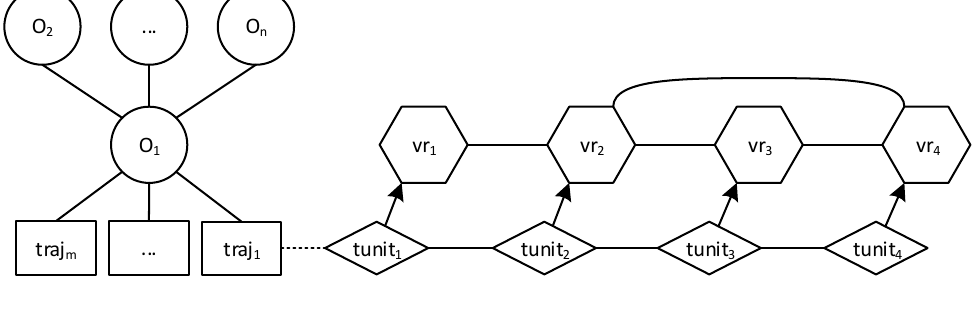
Figure 4. An example for the GSM